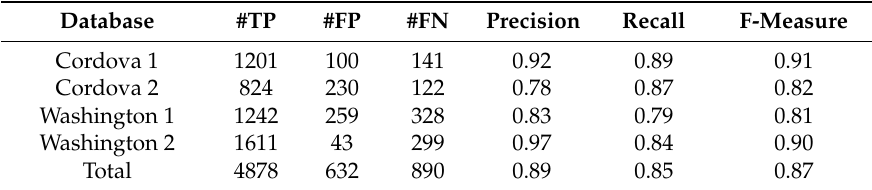
Table 4. Experimental results by our method with the Caltech datasets.